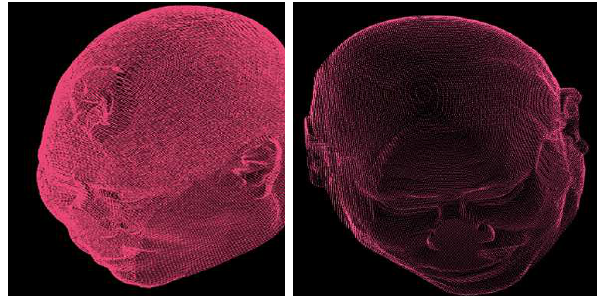
Fig.9 (a) Volume Element Working (b) Interpolation Working While points on the contours of tumor can increase or decrease abruptly depending on the shape of tumor. Thus we need to find a way to efficiently connect these different numbers of points. Algorithm